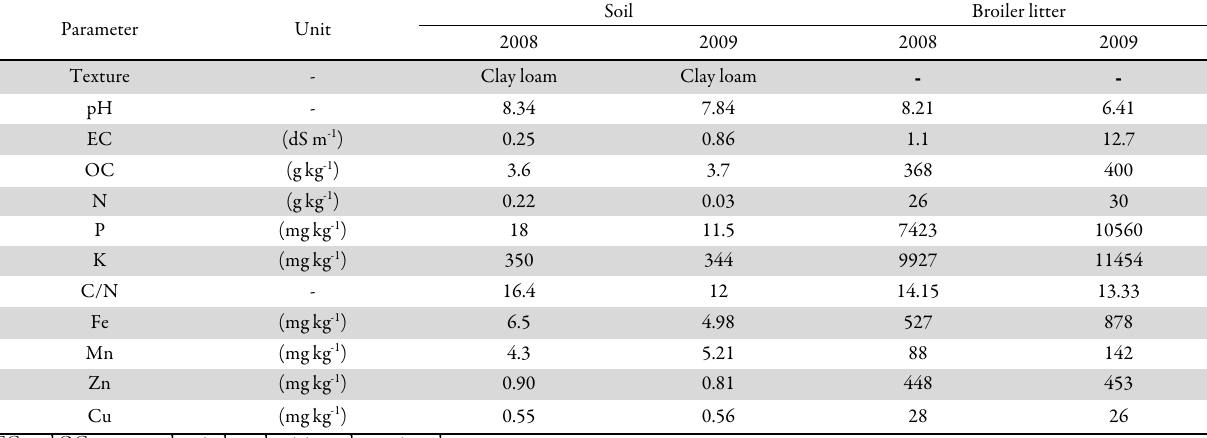
Table 1. Main variables of soil and broiler litter for the experiment